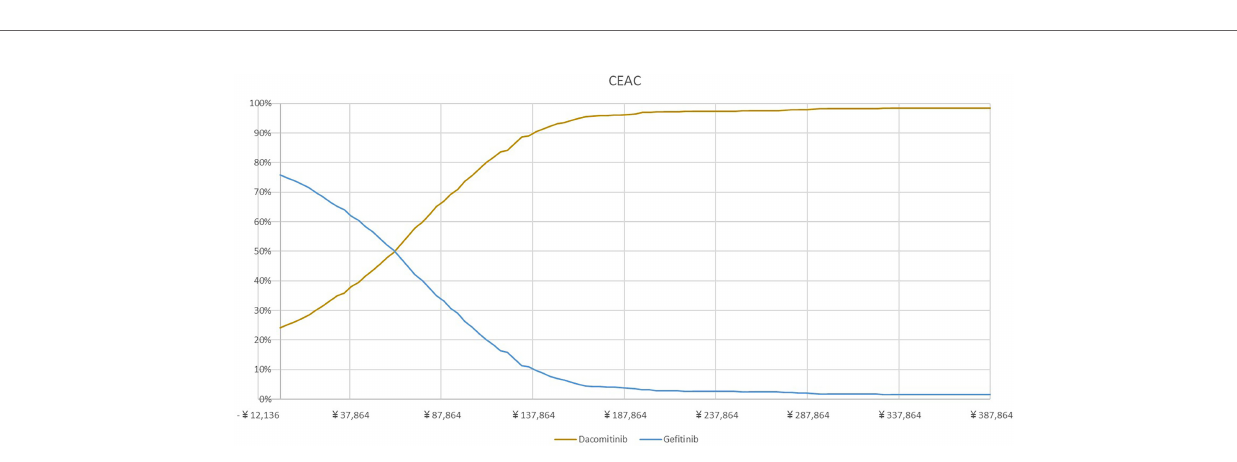
FIGURE 4 | Cost-effectiveness acceptability curve.